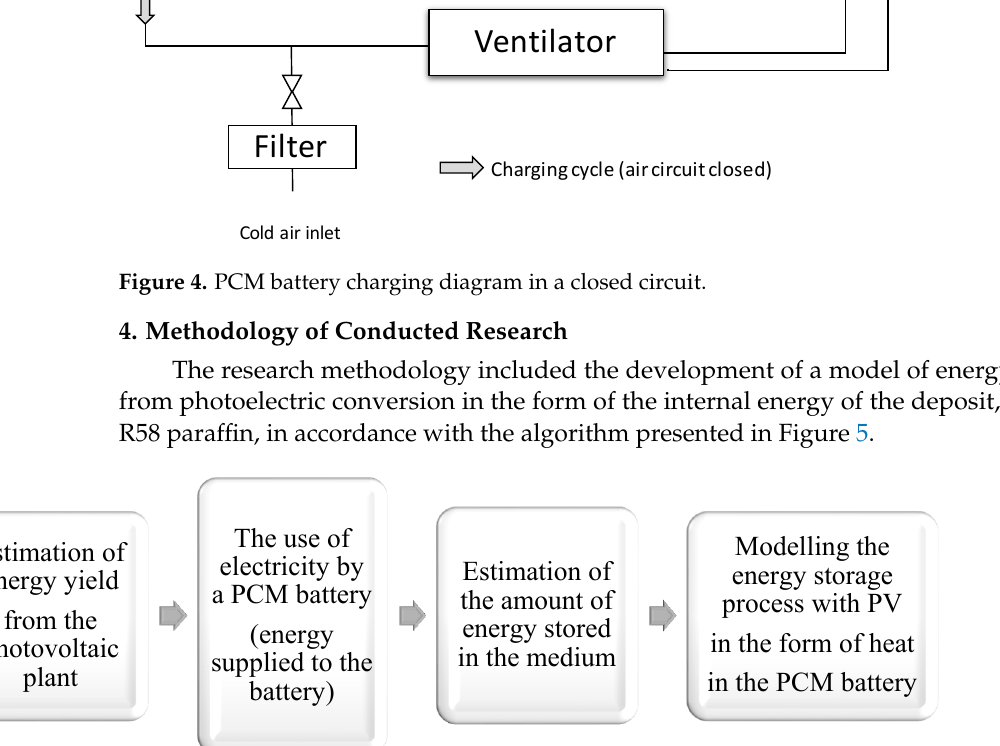
Figure 5. Block diagram of the stages of modelling the energy storage system in the PCM battery.